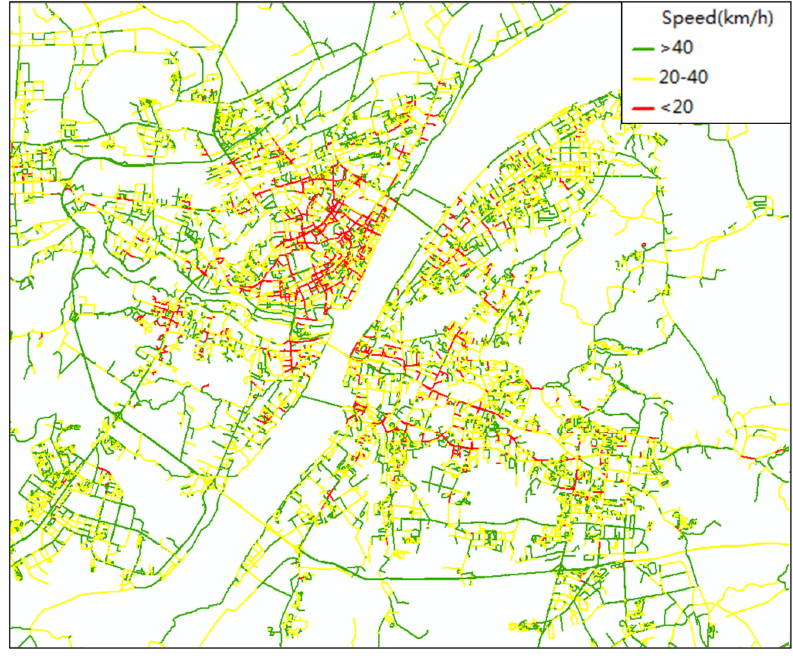
Figure 4. The road network of Wuhan City. Table 1. Computational performance of the four algorithms.